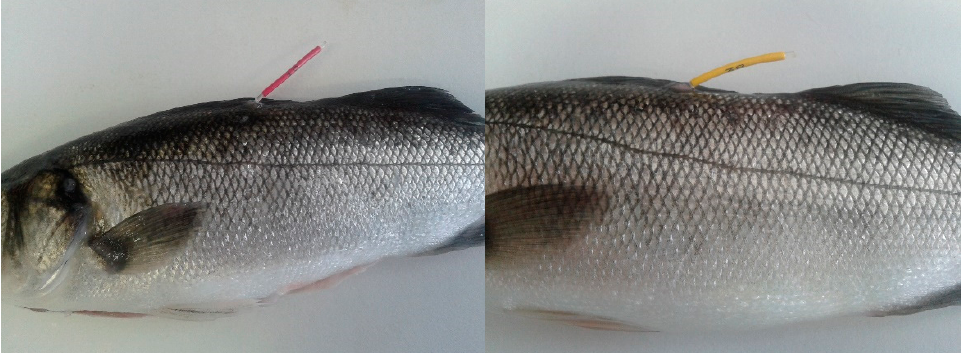
Figure 1. European seabass tagged with anchor tags of different colors and identification (ID)